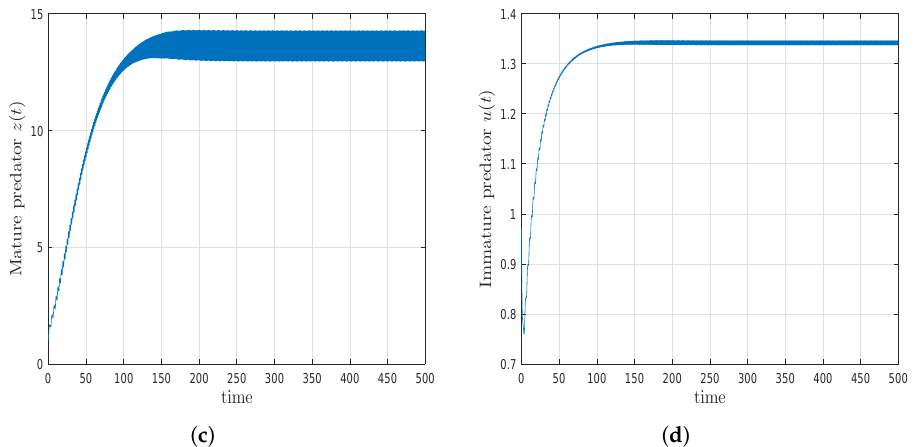
Figure 6. State variables x ( t ), y ( t ) z ( t ), and u ( t ) plots of food web mathematical System (13) with generalized Caputo fractional operator when ϕ = 1 and ρ = 1.2.